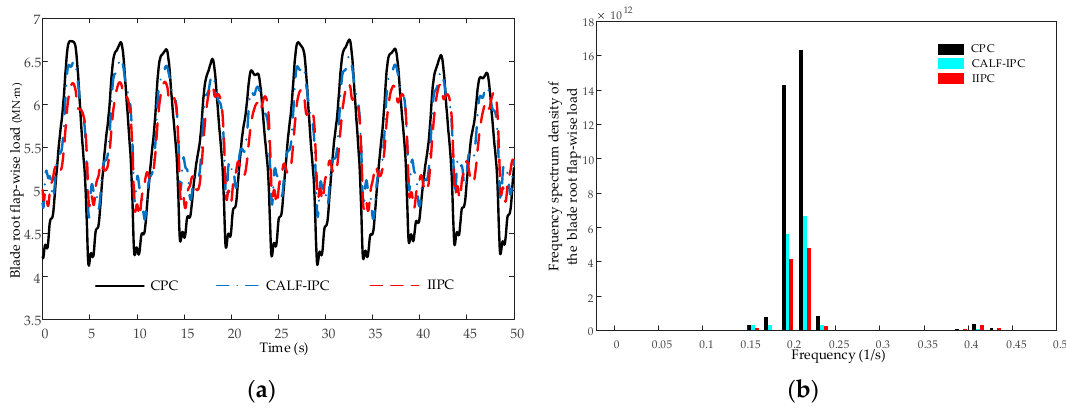
Figure 12. Time domain and frequency domain results of blade root flap-wise load under different control: ( a ) Curves of the blade root flap-wise load; ( b ) Frequency spectrum density of the blade root flap-wise load.